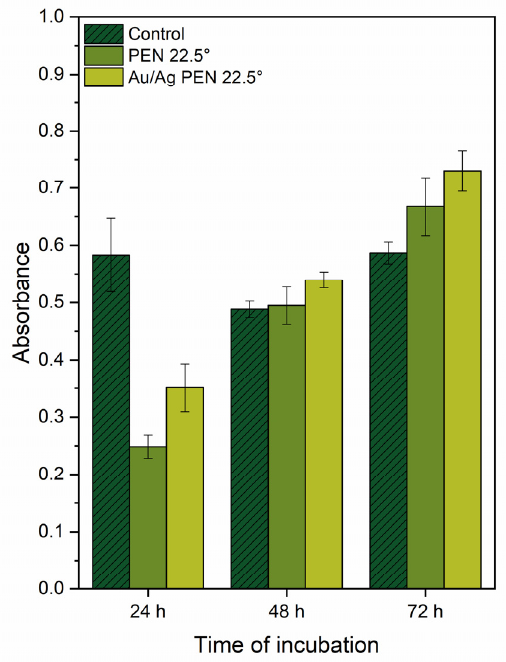
Figure 9. Decreasing cytotoxic effects of PEN 22.5° and Au/Ag PEN 22.5° samples, expressed by increasing absorbance.